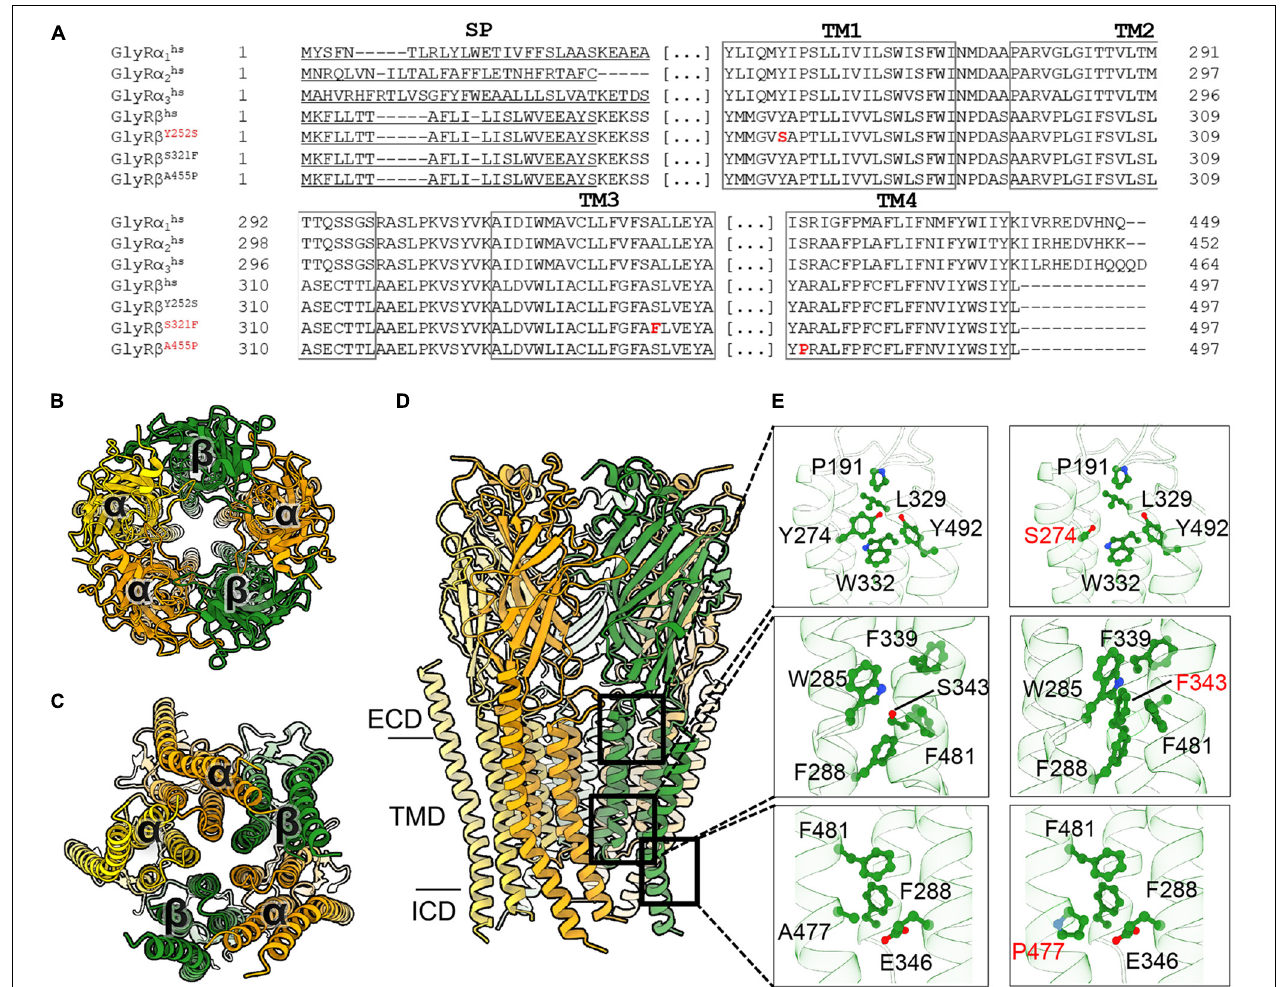
FIGURE 1 | Molecular modeling of novel GlyR β subunit mutants. (A) Alignment of GlyR subunits α 1, α 2, α 3, β subunits from human and the β subunit variants concentrating on transmembrane segments. Numbers of amino acid residues in mutant variants refer to non-mature protein, (SP) signal peptide. (B–D) Cartoon representation of the 3 α :2 β glycine receptor heteropentamer homology model viewed from extracellular domain (B) , from the intracellular side (C) and the membrane plane (D) . GlyR α -subunits are colored orange and yellow and β -subunits are colored in green. (E) Close-up views of the interaction of residues in WT (left panels) and the mutant (right panels) model. All critical residues are shown as ball and stick, whereas the backbone is shown in cartoon representation, numbering refers to mature